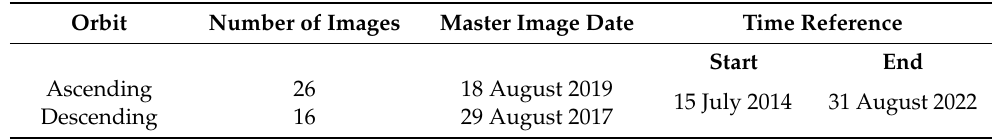
Table 2. List of the Sentinel 1 data acquired in this study. Orbit Number of